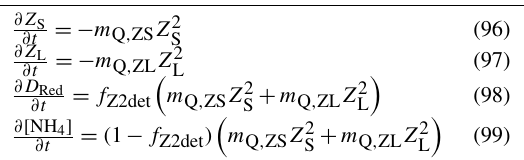
Table 17. Equations for the zooplankton mortality. f Z2det is the fraction of zooplankton mortality that is remineralised and is equal to 0.5 for both small and large